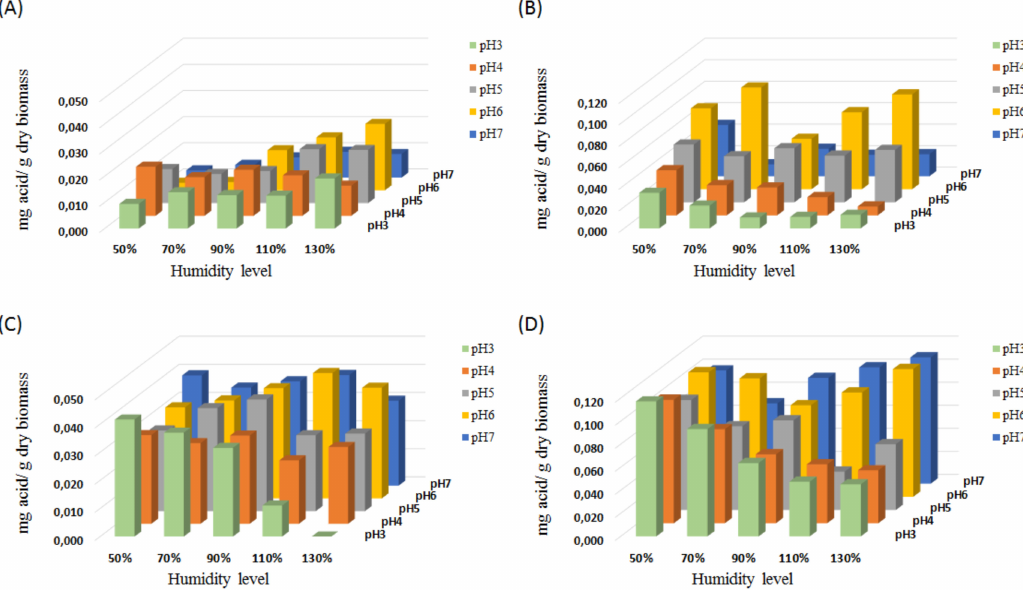
Figure 2. Solid-state fermentation (SSF) on corn cobs at di ff erent pH and moisture levels by A.